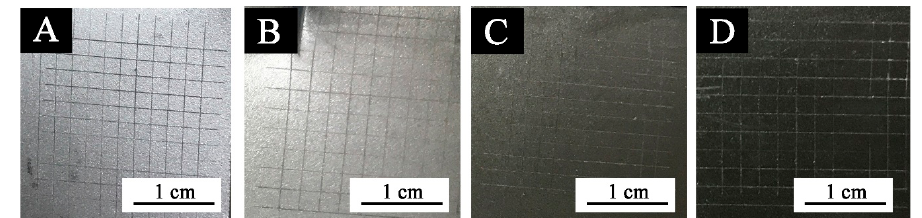
Figure 4. Influence of black paste content on adhesion of the coatings.